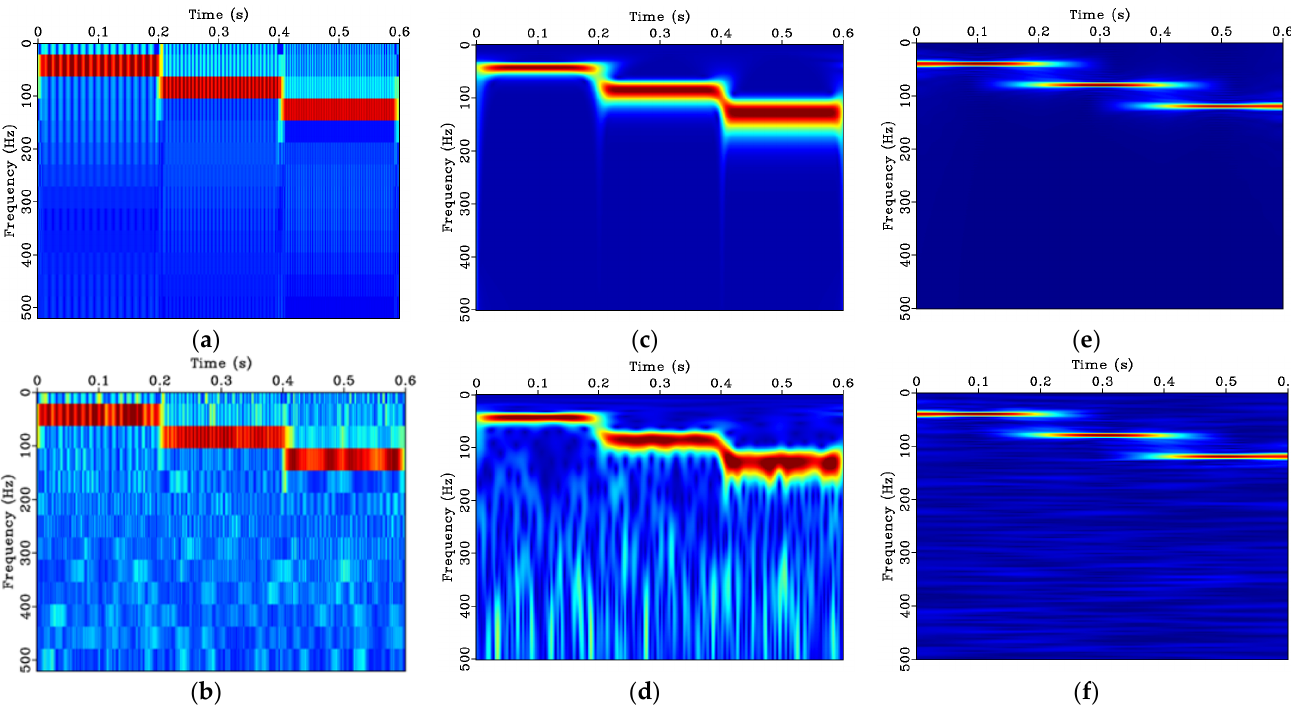
Figure 6. Time-frequency spectra for the constant-frequency step signal: ( a ) STFT spectrum; ( b ) STFT spectrum of noisy signal; ( c ) ST spectrum; ( d ) ST spectrum of noisy signal; ( e ) LTFT spectrum; ( f ) LTFT spectrum of noisy signal. The jet colormap is used where blue and red represent low and high frequency magnitudes, respectively.